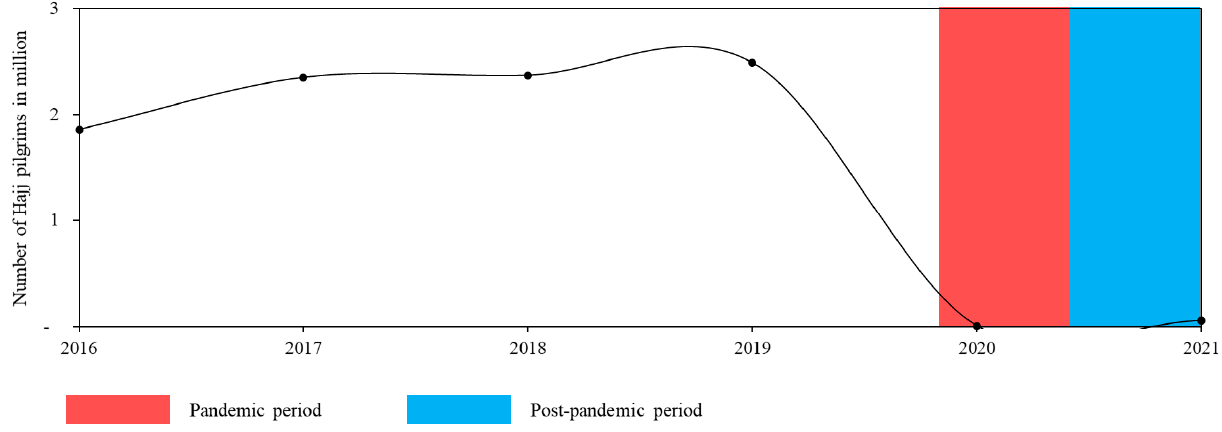
Figure 10. Annual (sum) temporal profile of Hajj pilgrims from 2016 to 2021 (source: [7]).